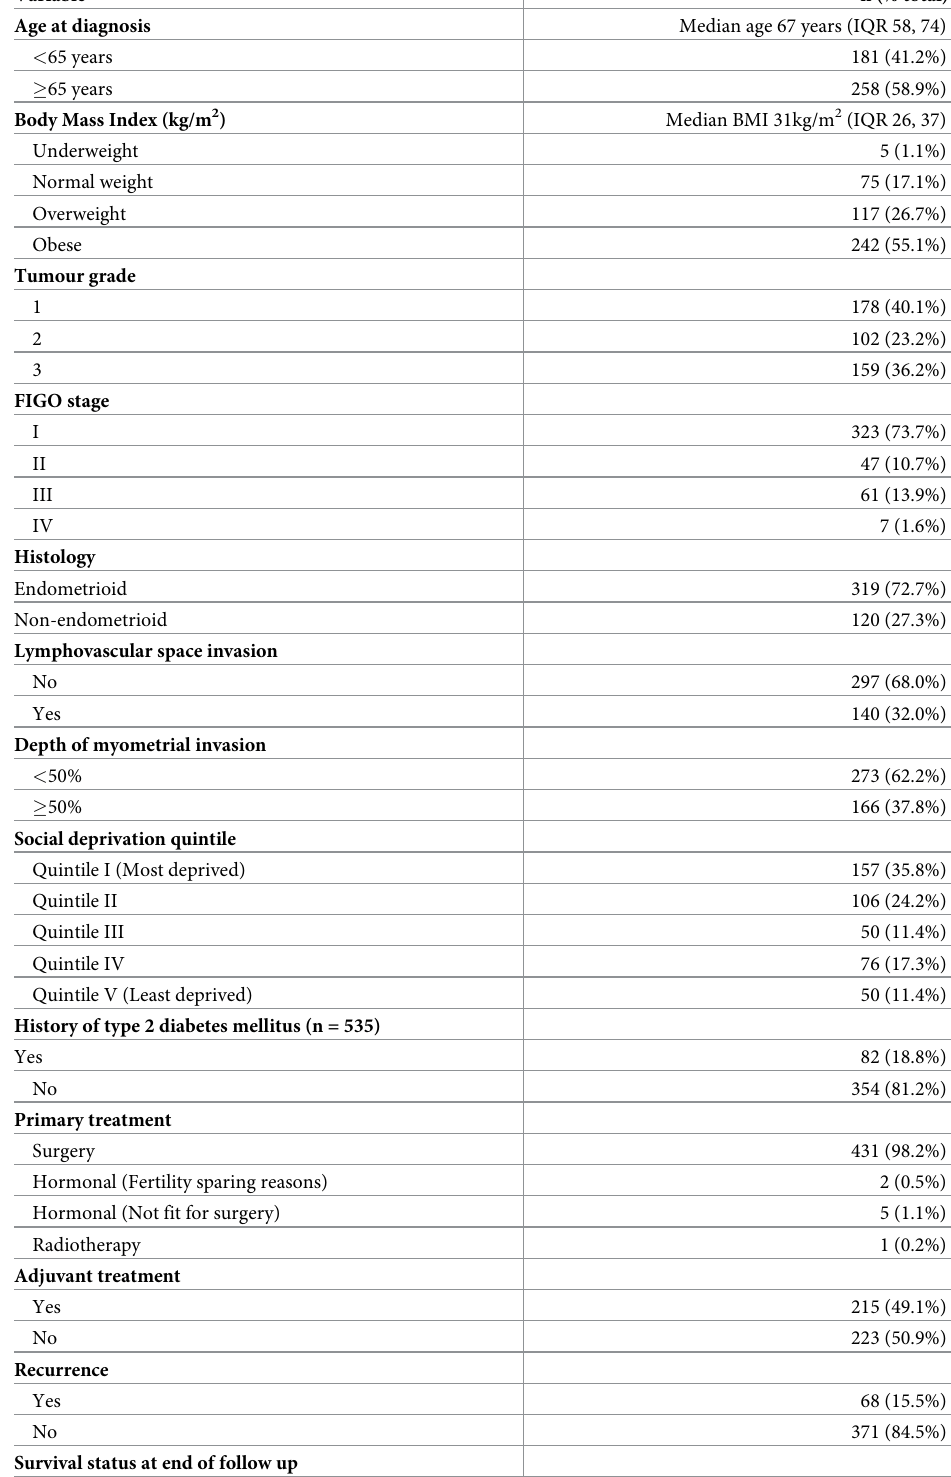
Table 1. Socio-demographic characteristics of the study